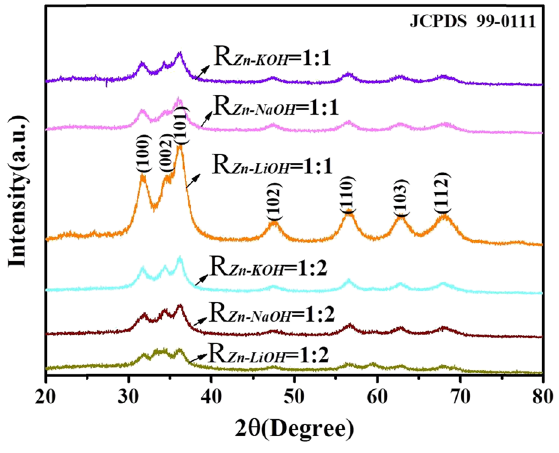
Figure 2: XRD pattern of ZnO QDs synthesized under di ff erent alkali bases and R Zn − OH